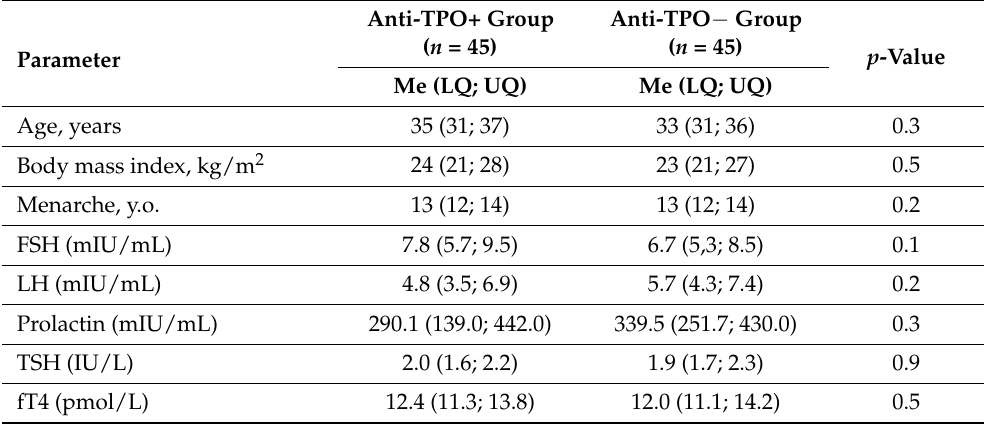
Table 1. Comparative analysis of age-related, anthropometric and hormonal parameters within the